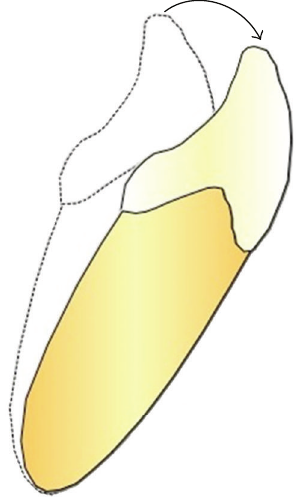
Figure2: Thepictureshowstheflaring movement inalower